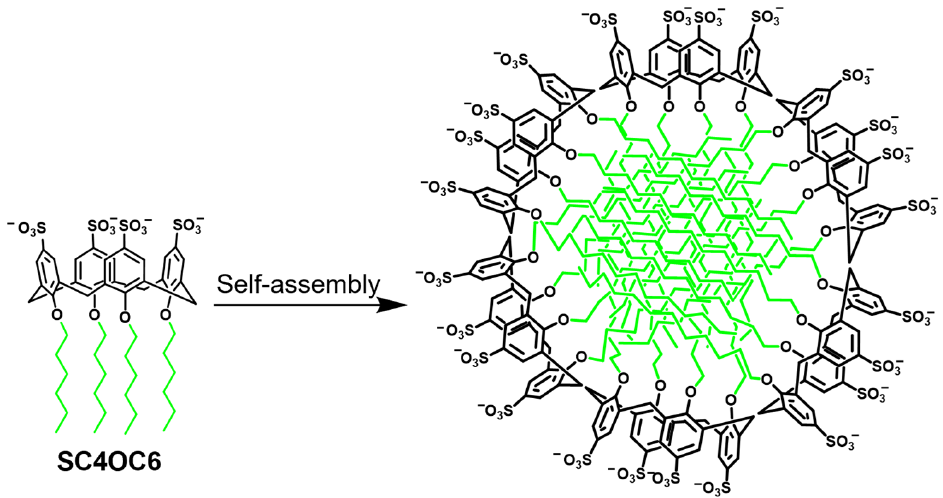
Figure 1. Schematic representation of the SC4OC6 structure and its self-assembling in a micellar